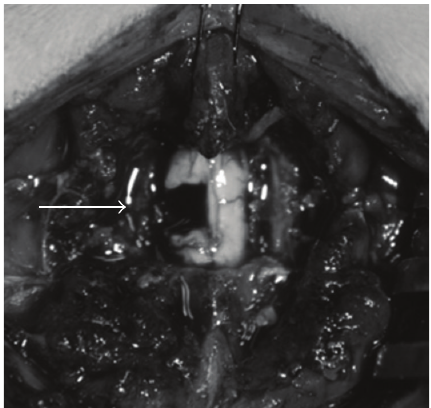
Figure 1: Photograph of the C2 − C5 laminae. White Arrow: C3/C4 spinal cord hemisection showing a 2 mm